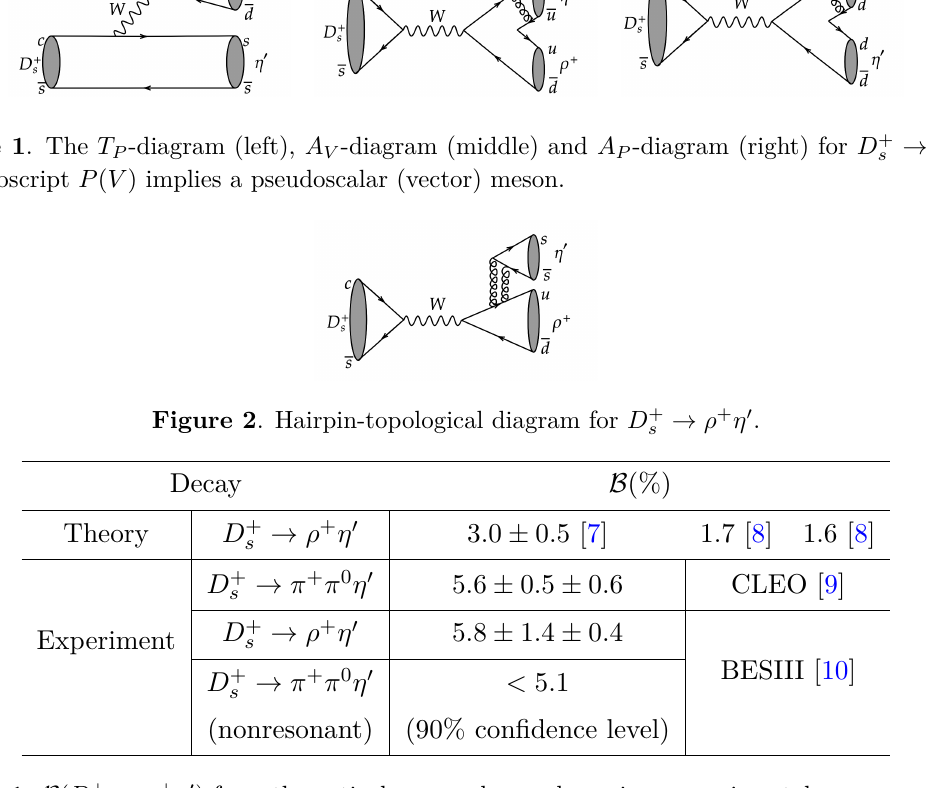
Table 1 . B ( D + → ρ + η 0 ) from theoretical approaches and previous experimental s